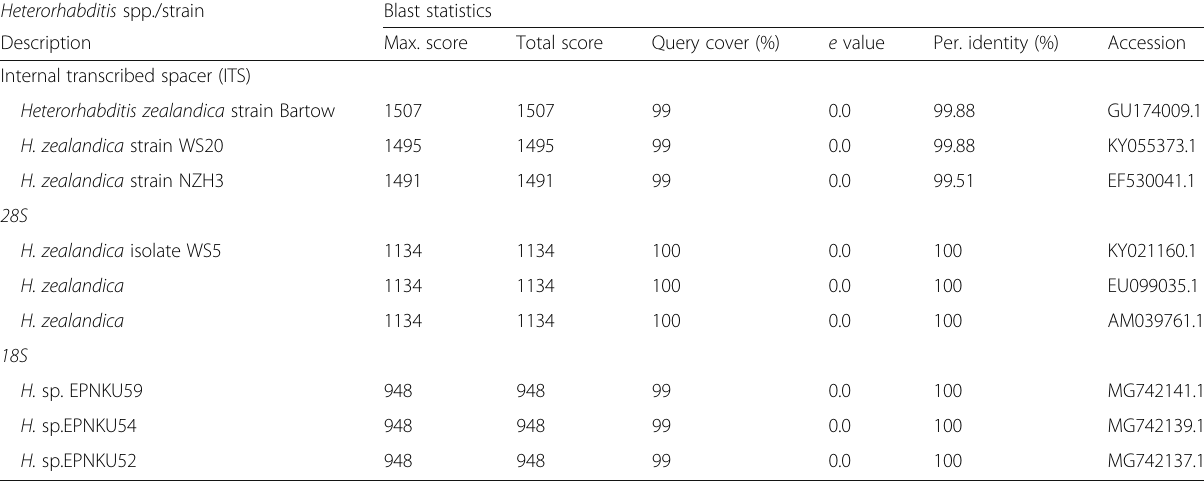
Table 1 The BLAST results including three significant hits for each molecular marker used in the study for Heterorhabditis zealandica strain ETL Heterorhabditis